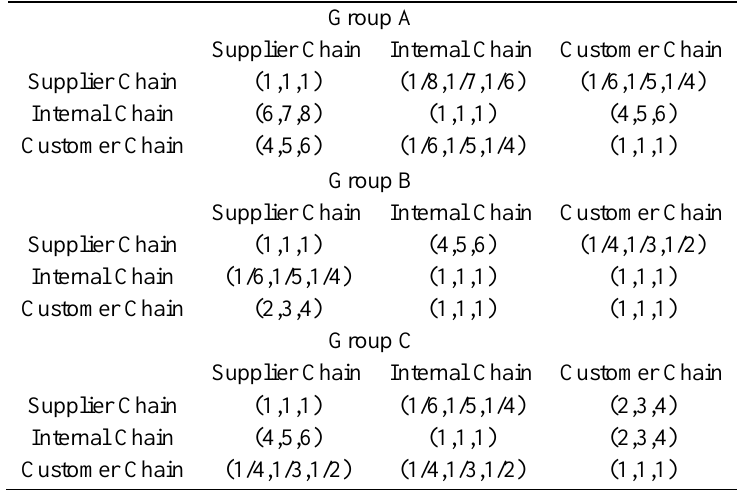
Table 4. Pair wise comparison matric of major part.